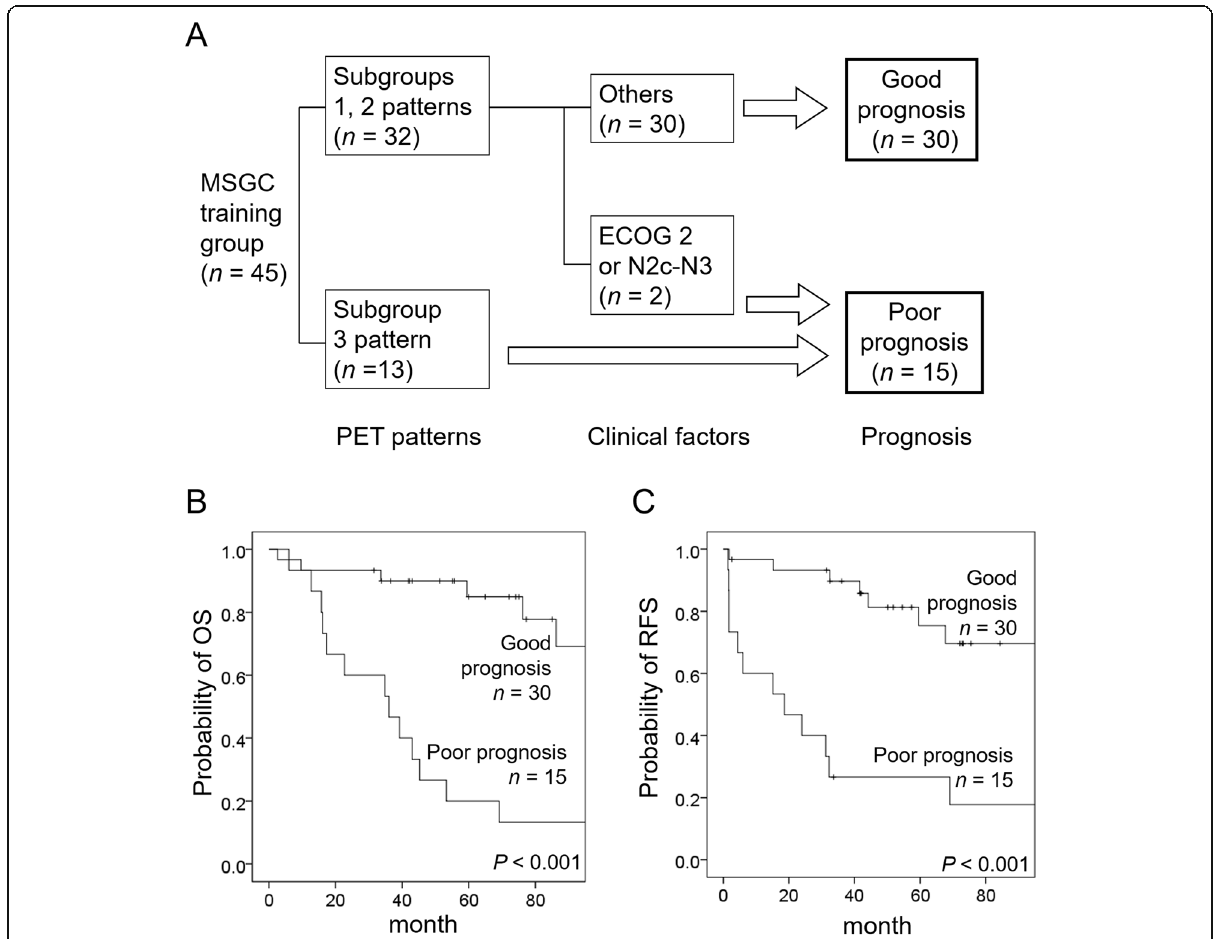
Fig. 2 Development of the prognostic model based on the high-risk PET pattern and N2c-N3 stage or poor performance status ( a ). Kaplan-Meier plots of OS ( b ) and RFS ( c ) according to the prognostic model in the training